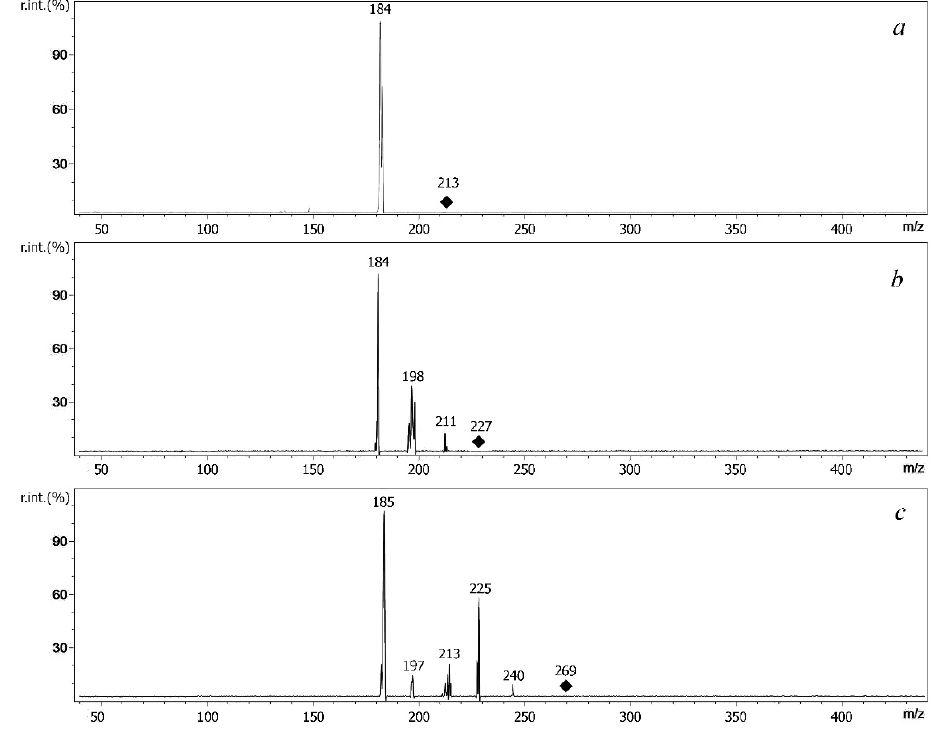
Figure 4. CID mass spectra (collision energy 30 eV) of S-ethylsulfonium cations corresponding